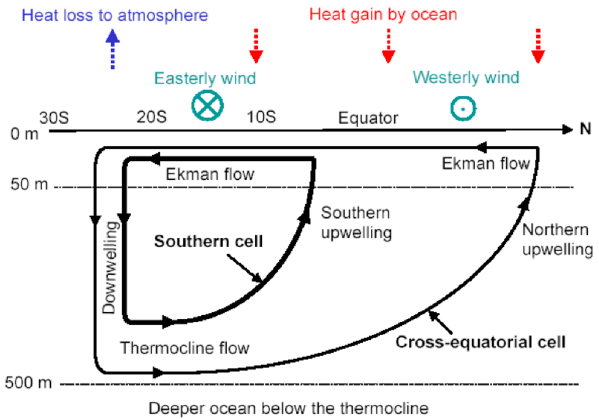
Figure 28. Conceptual illustration of the time-mean Meridional Overturning Circulation of the upper Indian Ocean that consists of a southern and a cross-equatorial cell. The time-mean zonal wind and surface heat flux are also shown schematically. This flow is believed to partially supply the cross-equatorial thermocline flow. From Lee